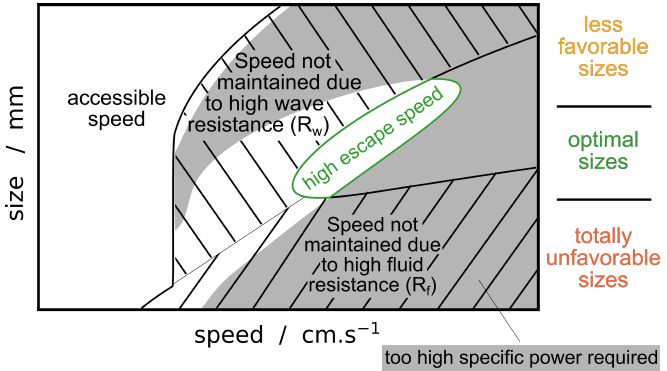
Figure 8. Scheme of the constraints that limits whirligig beetles water-air interface